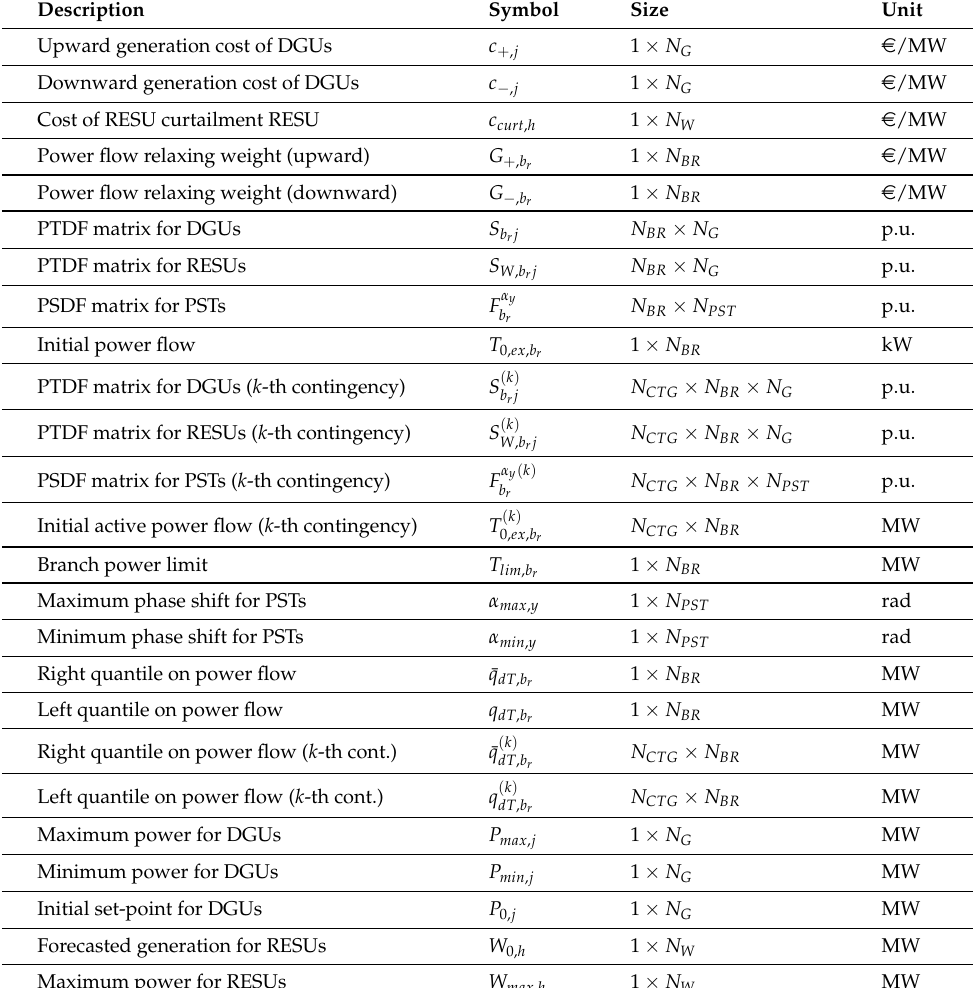
Table 1. Parameters for the optimal active power control algorithm.